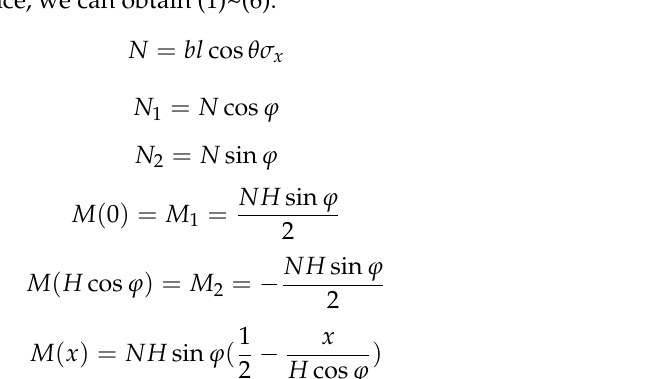
Figure 3. Forces and moments correspond to the homogenized x direction tensile properties. By the moment balance, we can obtain (1)~(6):